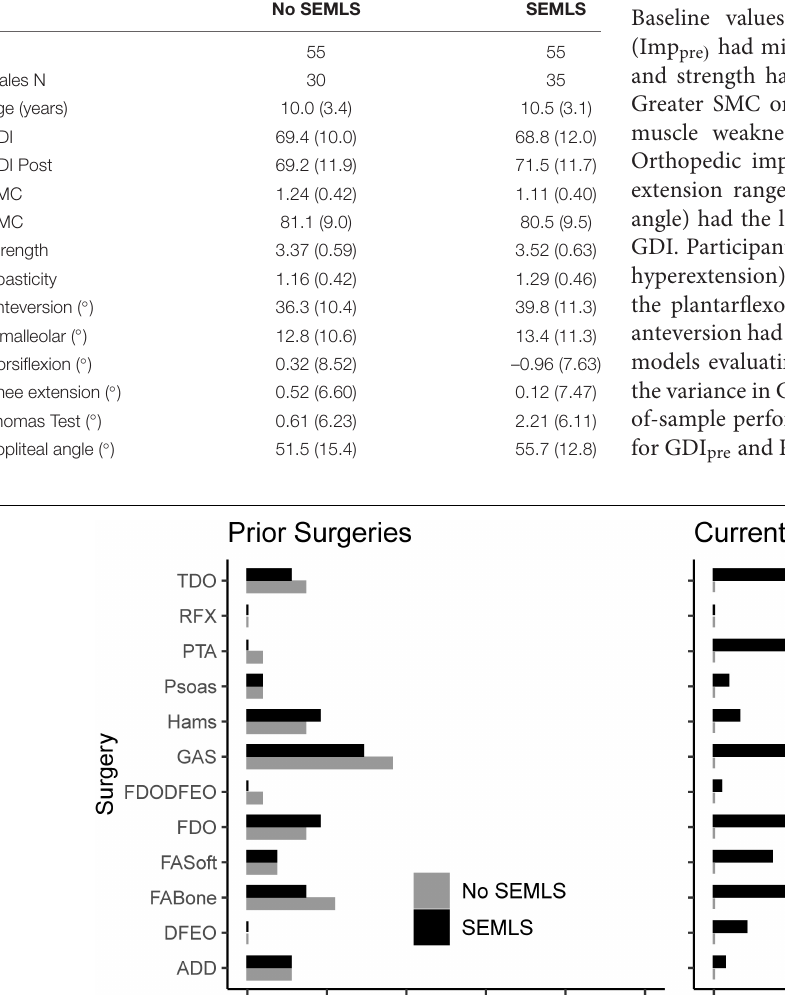
Frontiers in Human Neuroscience |